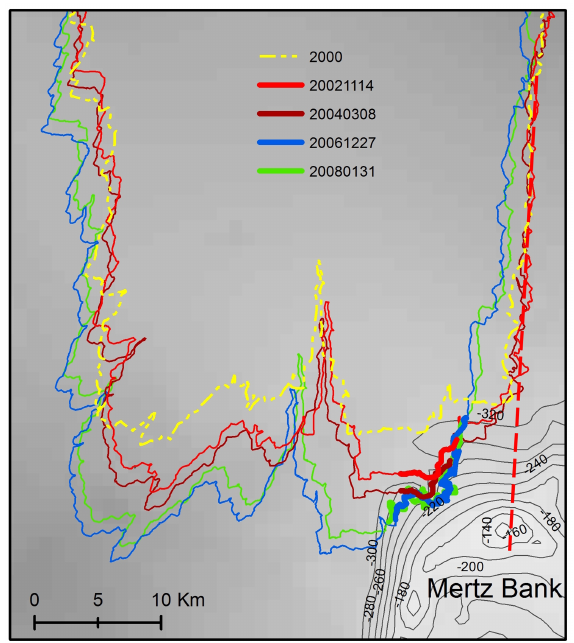
Figure 7. Digital elevation map (DEM) of seafloor around the Mertz and grounding section of the boundaries extracted from 2002 to 2008. The grounding sections of the MIT boundary from 2002, 2004, 2006, and 2008 are marked with thick red, purple, green and blue polylines, respectively, and the MIT boundaries are indicated with polygons with the same legend as in Fig. 3a. Additionally, the MIT boundary from 2000 indicated with dash-dotted yellow poly- gon is used to show the different quality of the seafloor DEM. Inside this polygon no bathymetry data were collected or used. The dashed red line indicates the “extension line” of the west flank of the MIT on 14 November 2002, passing the shallowest region of the Mertz Bank (approximately − 140m).